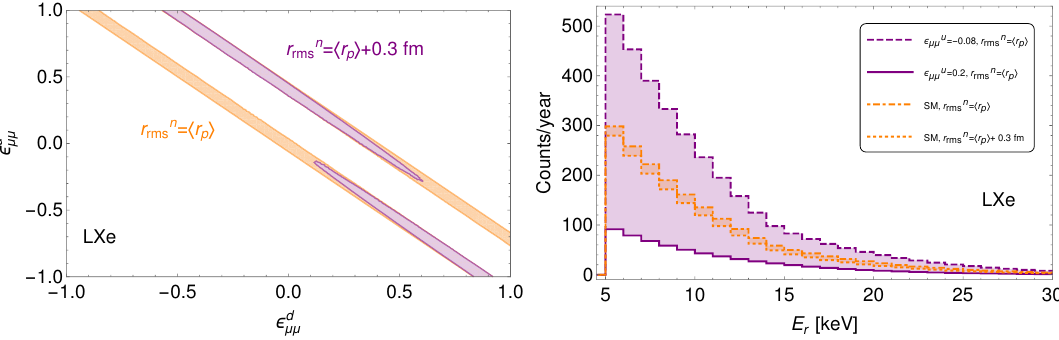
Figure 5 . Left : 90% C.L. allowed regions in the NSI case and for two choices of the rms neutron radius. The diagonal bands are obtained assuming r n = h r p i = 4 : 79 fm for all xenon isotopes. rms The purple regions are obtained for r n = 5 : 09 fm (for all isotopes). Right : number of events rms as a function of recoil energy for (cid:15) u (cid:26) [ (cid:0) 0 : 088 ; 0 : 37] [6] and all other couplings equal to zero (cid:22)(cid:22) (purple histograms). The orange histograms correspond to the SM prediction including form factor